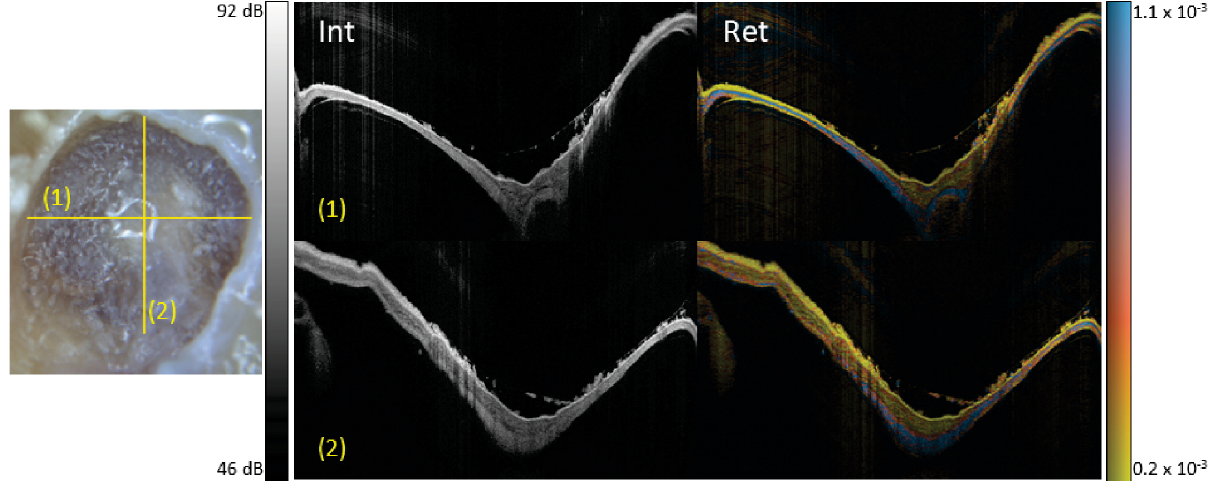
Figure 1. Photographic overview of the tympanic membrane (left) of a right temporal bone specimen with marked positions, (1) and (2), of the exemplary PSOCT B-scans. Intensity (middle column) and estimated local retardance (right column) images are 7 . 6mm in lateral direction and 3 . 15mm in axial